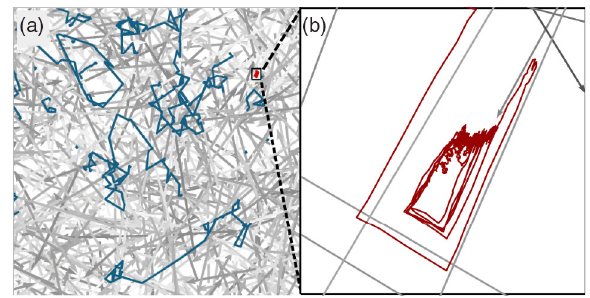
FIG. 4. Single-particle trajectories reveal a cycling state. (a) Representative simulation trajectories (blue and red) projected onto the filament network (gray). (b) A magnified view of a cycling trajectory (red).